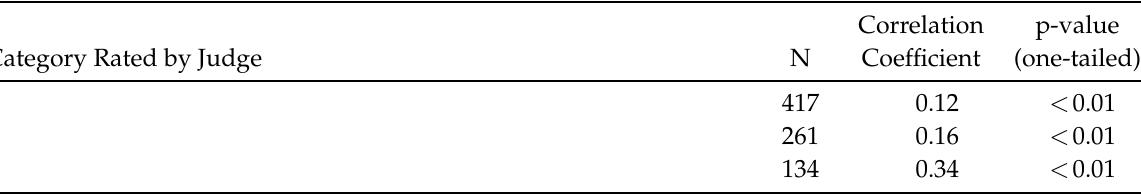
Table 2: Correlation of adjusted judge’s prediction with target’s